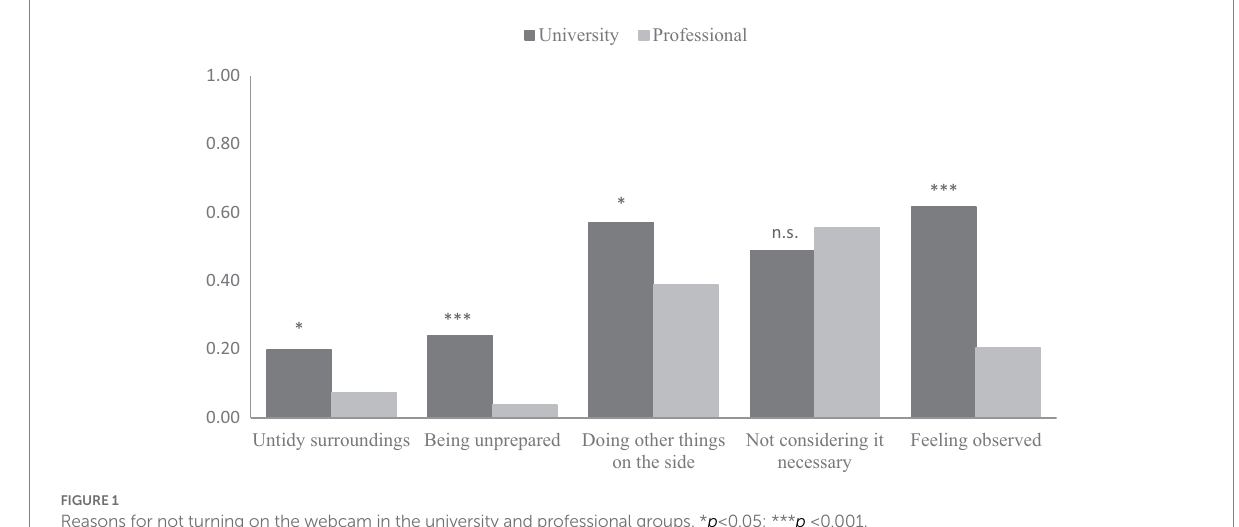
FIGURE 1 Reasons for not turning on the webcam in the university and professional groups. * p < 0.05; *** p <